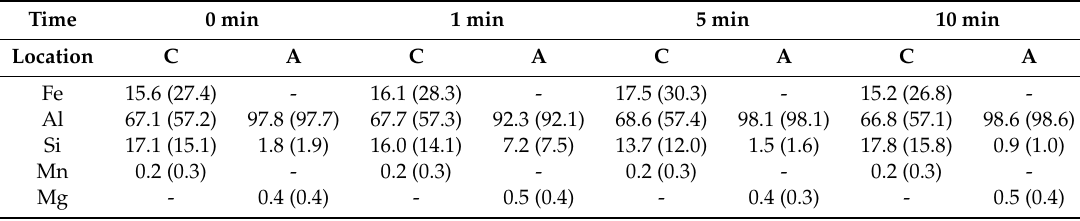
Table 3. Concentrations (at.%) of intermetallic compounds (C) at the interface of cast iron / liquid Al–Si alloy and aluminum matrix (A) near the interface with respect to the holding time (numbers in parentheses indicate weight